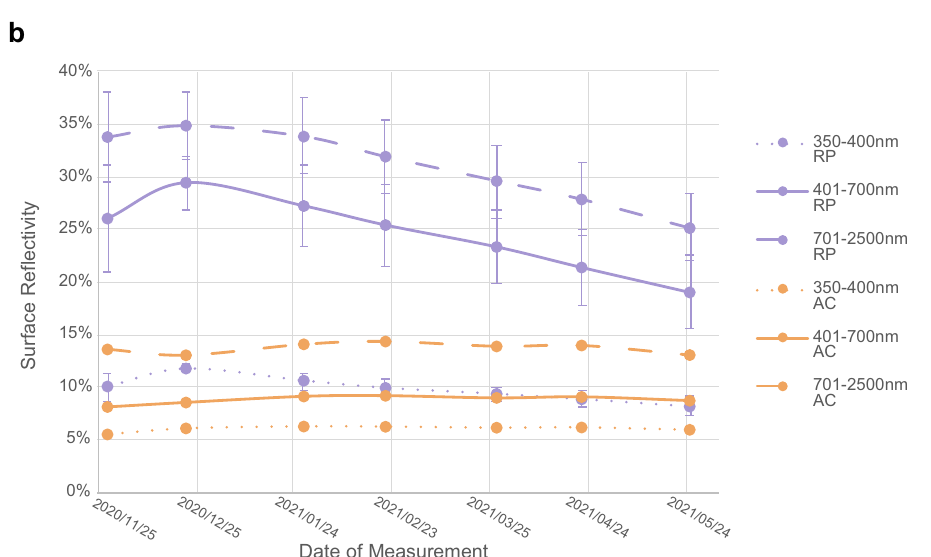
Fig. 6 | Surface re fl ectivity measurements in all areas (a) and over time (b). a Re fl ectivity in November 2020 compared to May 2021 across all wavelengths, excluding strong water vapor and carbon dioxide absorption windows (1350 – 1450nm; 1800 – 1950nm; 2300 – 2500nm). b Solar re fl ectivity over time for re fl ective pavement (RP) and asphalt concrete (AC) across three wavelength ran- ges: dotted line — ultraviolet A (UVA; 350 – 400nm), solid line — visible (VIS;